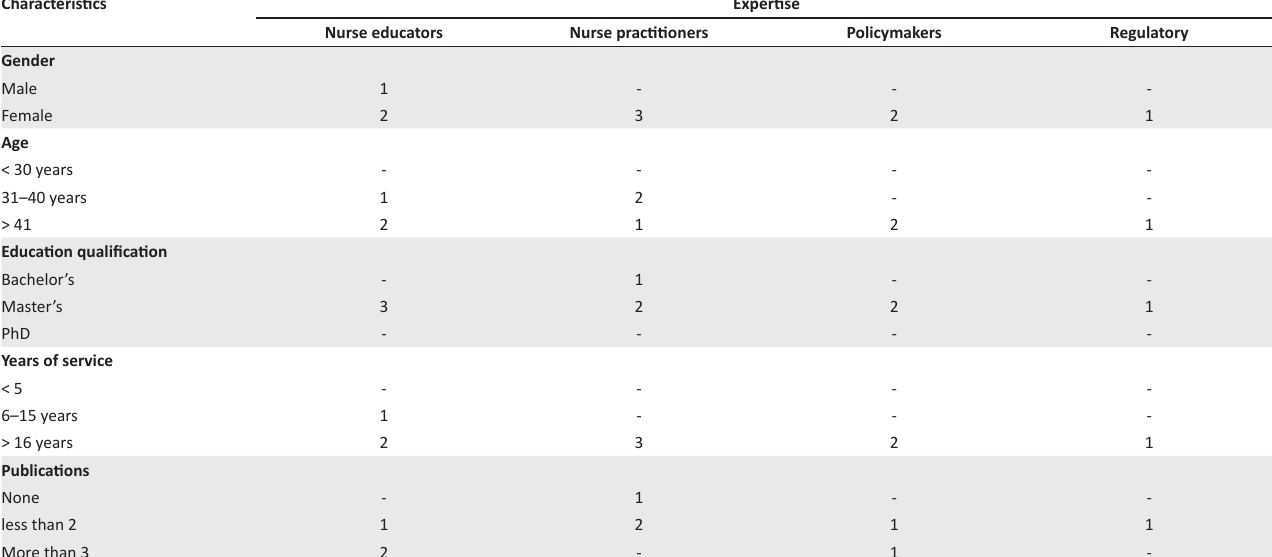
TABLE 2: Characteristics of panel discussion experts.